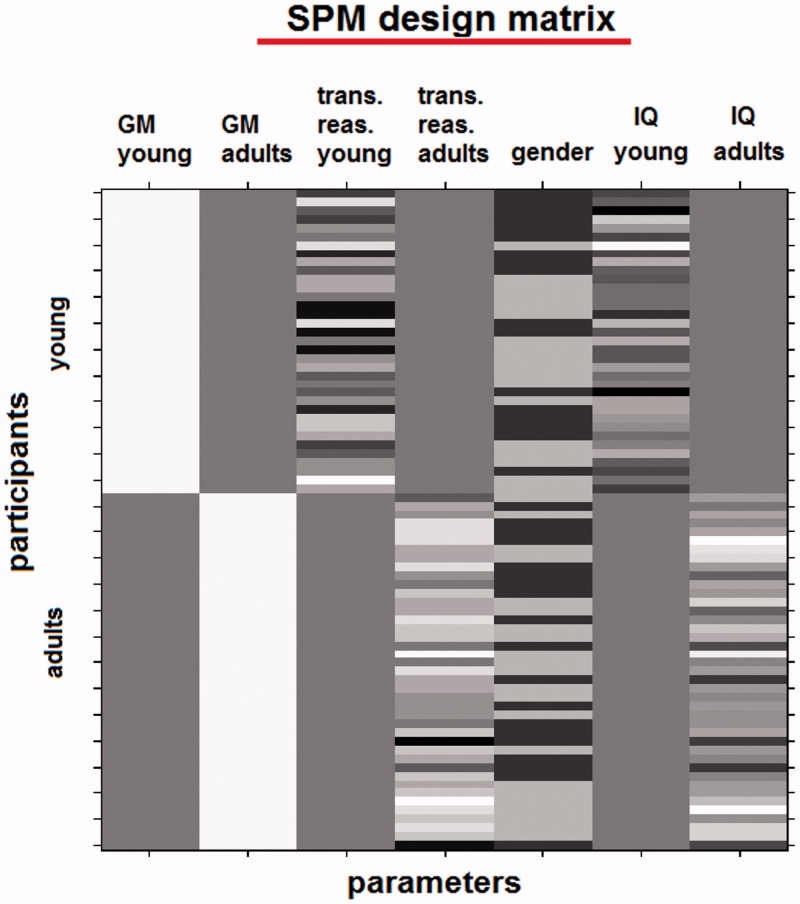
The SPM design matrix used in this study consists of seven parameters (columns): two for the grey matter images of the adolescents and the adults, two for the transitive reasoning scores of the adolescents and the adults, and three parameters of no interest (to remove the influence of gender, adults IQ, and adolescents IQ). This model allows testing for different regression slopes in adolescents and adults between grey matter density and transitive reasoning scores. Every row corresponds to the data of one participant. In the IQ and reasoning columns (i.e. columns 3, 4, 6 and 7), darker cell colors depict lower scores (brighter cell colors depict higher scores). In the gender column, dark grey cells depict women and light grey cells depict men. (Note: The first and second columns depict the grey matter images and no color code is applicable there. The big dark gray rectangles depict values that are not applicable to be modeled because they correspond to the other age group).